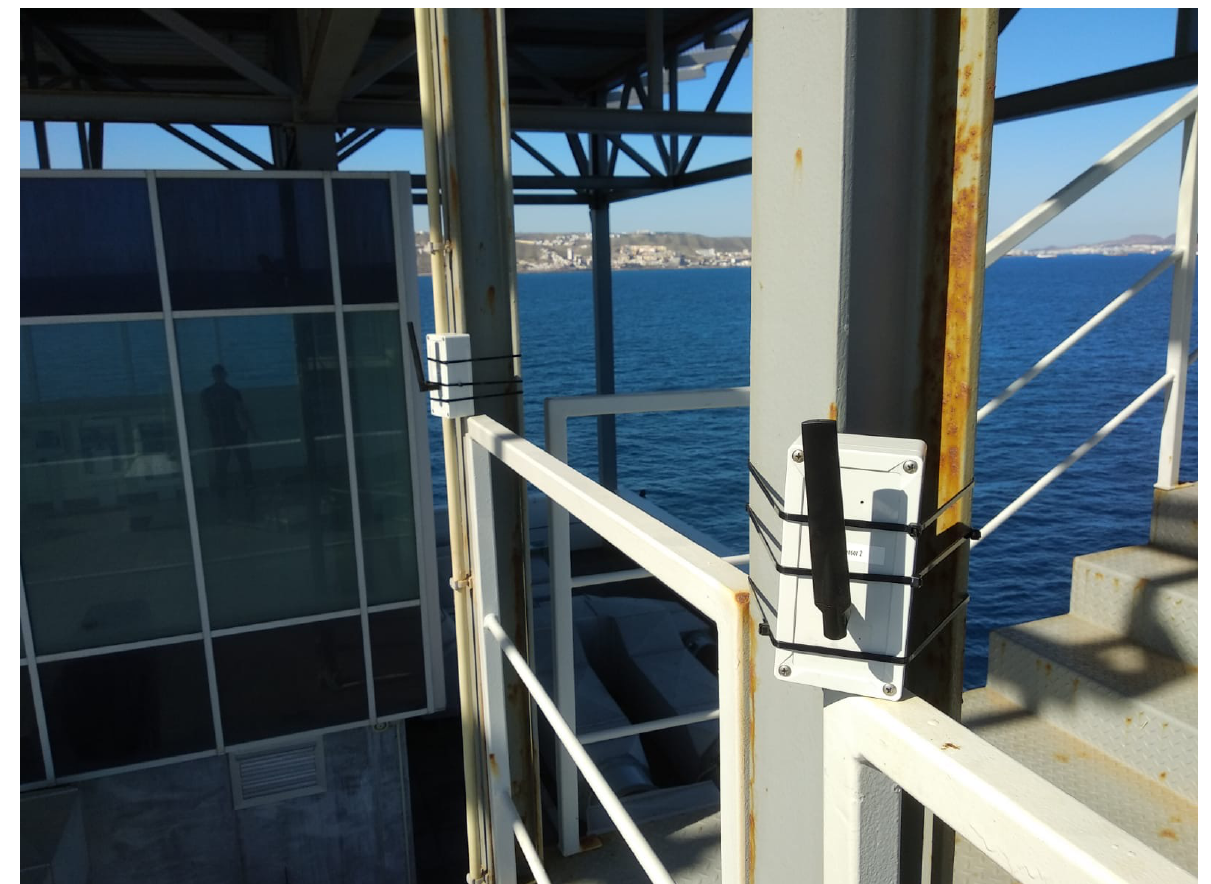
Figure 1. The sensor nodes deployed in the PLOCAN offshore